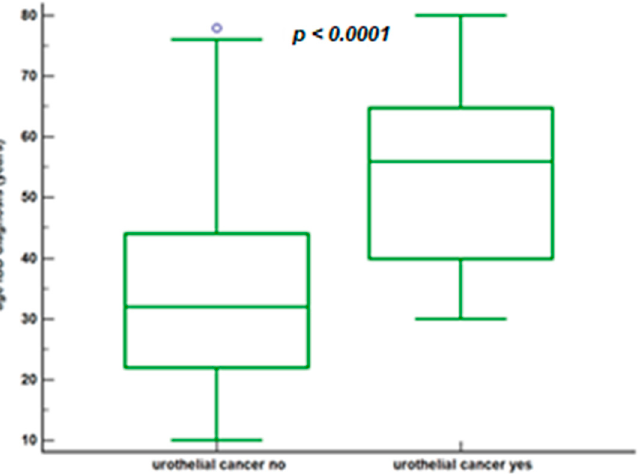
Figure 3. Age at diagnosis of IBD based on whether or not urothelial cancer has developed.